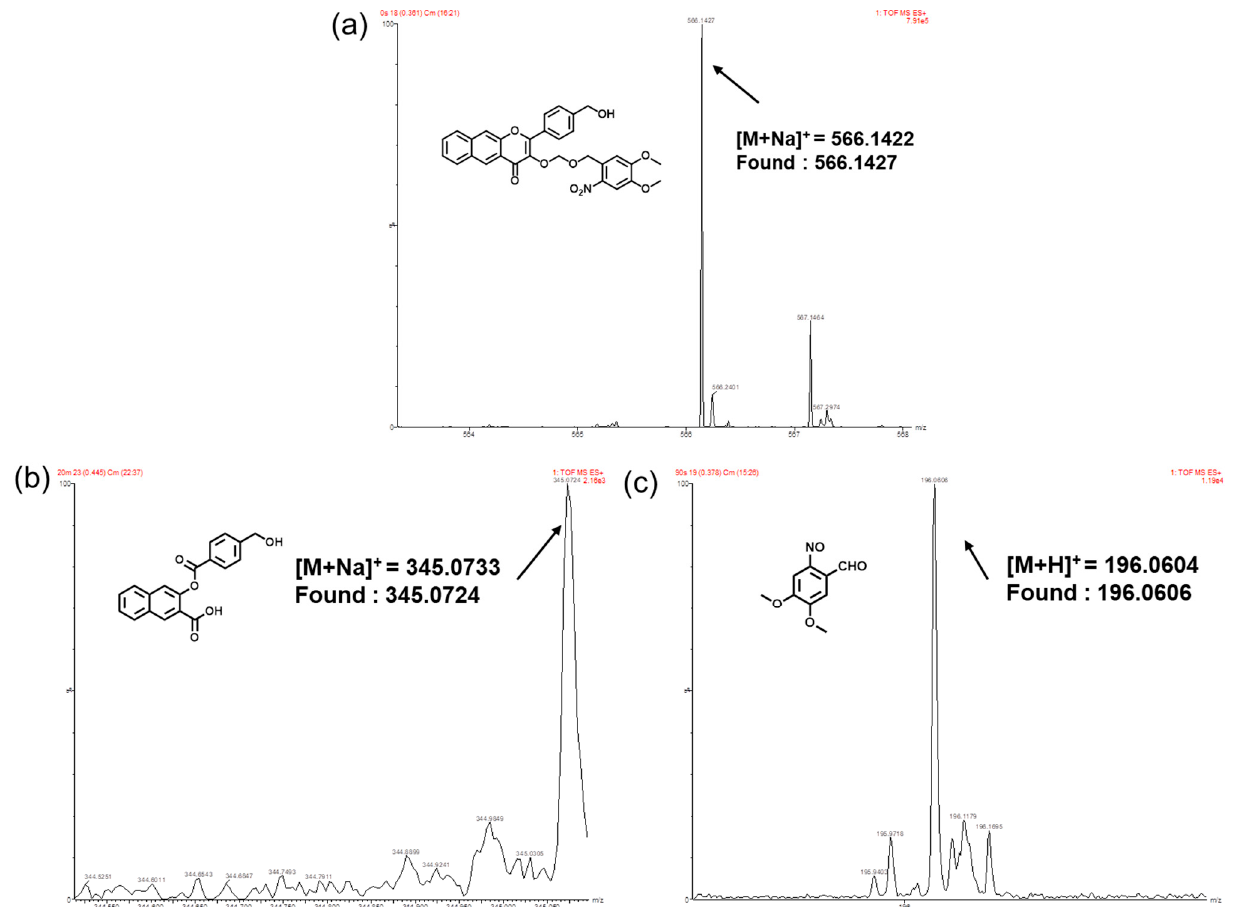
At the same time, they can be considered as nano-carriers to deliver other therapeutic reagents. Figure 4. ESI mass spectra recorded for compound B without ( a ) or with ( b , c ) irradiation for 20 min. under 410 nm (28 mW/cm 2 ) .